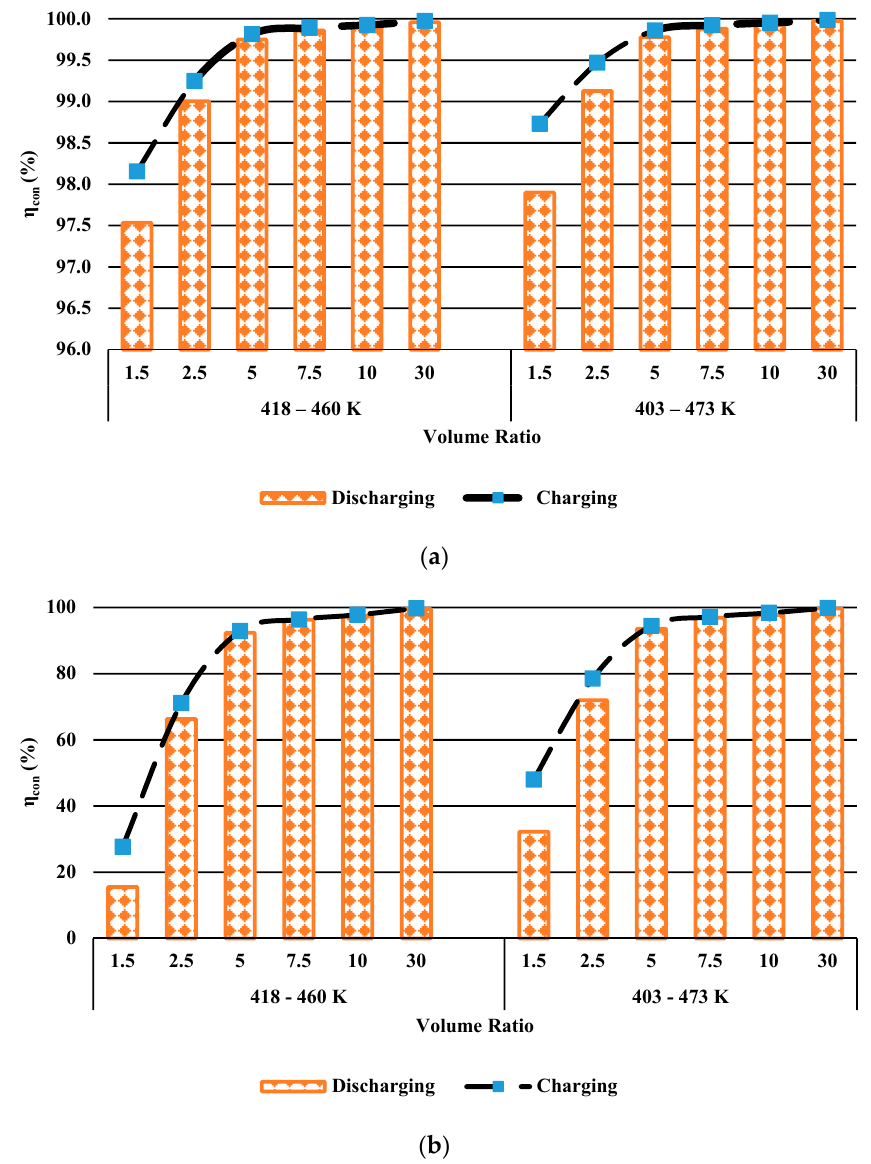
Figure 8. Contracted energy efficiency change in terms of volume ratio and inlet temperature rate for charging and discharging ( a ) 0.3 m 3 /h ( b ) 3.8 m 3 /h.